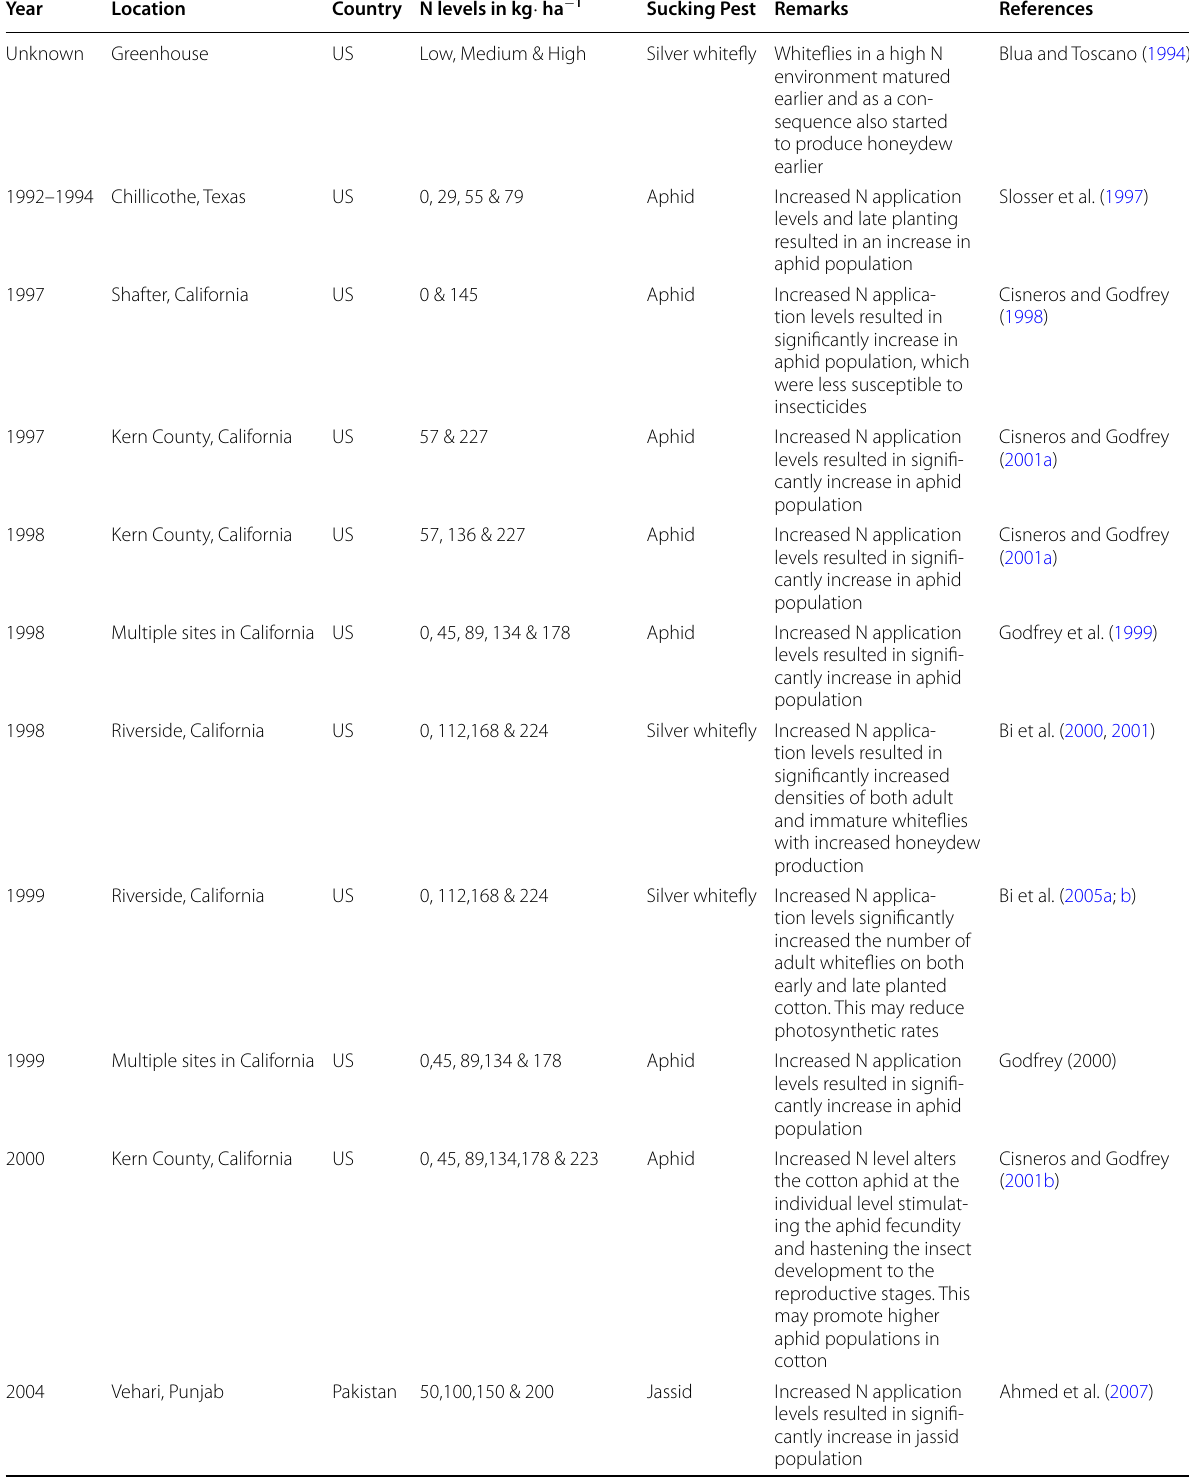
Table 7 Effect of N level on